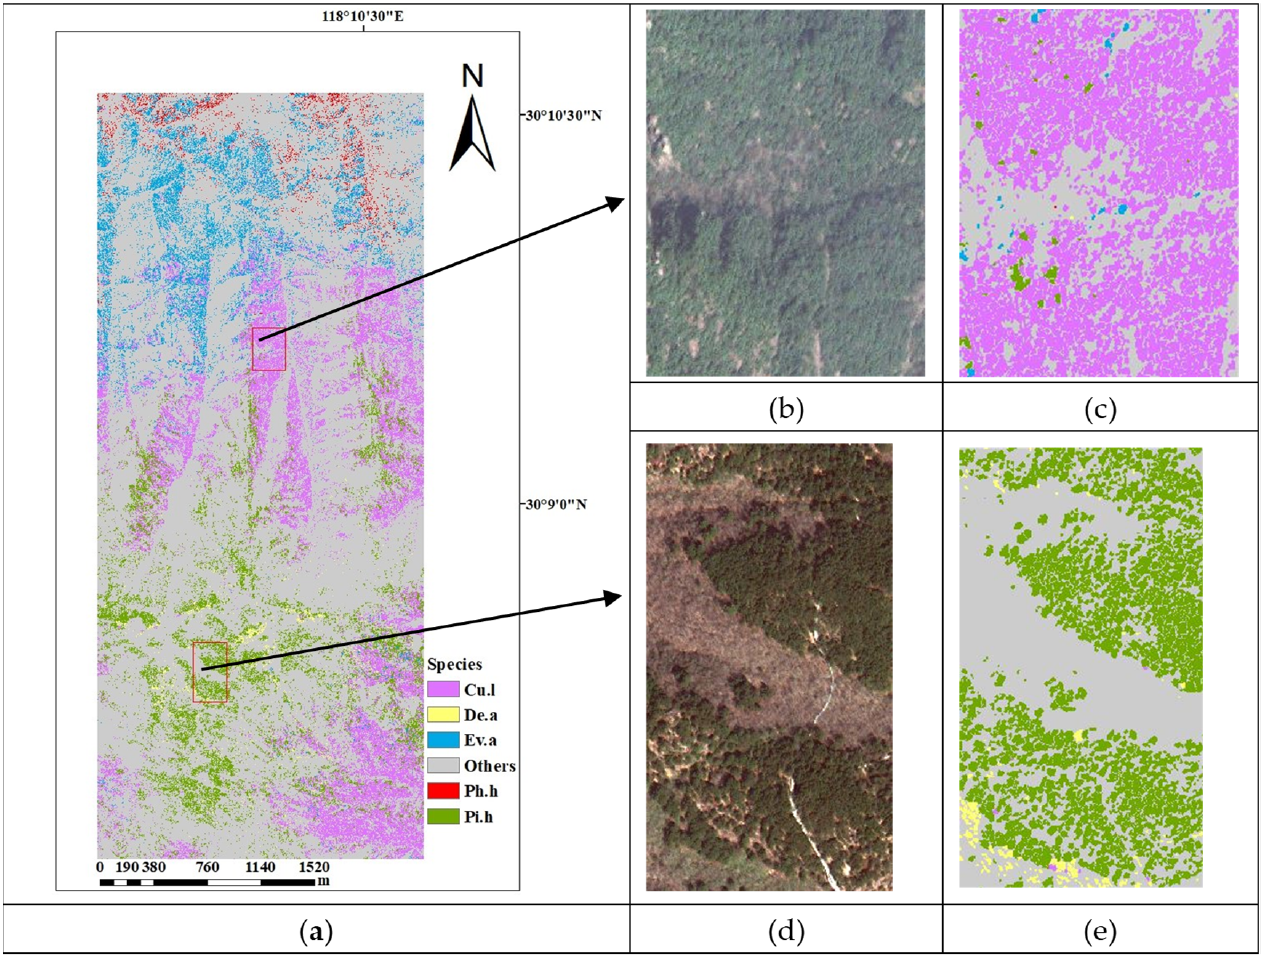
Figure 10. The tree species distribution map of the study area. ( a ) The overall tree species distribution in the study area. ( b ) Enlarged WorldView-3 imagery area 1. ( c ) Enlarged tree species distribution map area 1. ( d ) Enlarged WorldView-3 imagery area 2. ( e ) Enlarged tree species distribution map area 2.